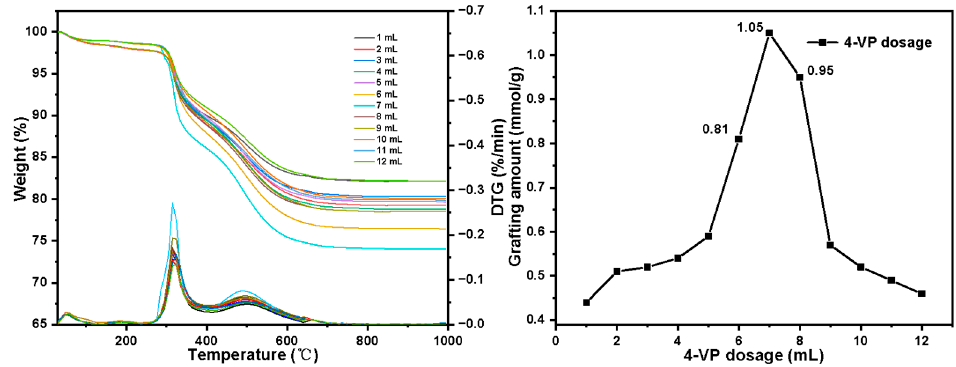
Figure 11. Grafting amount varies with 4-VP dosage change. Influence of reaction temperature on grafting amount: